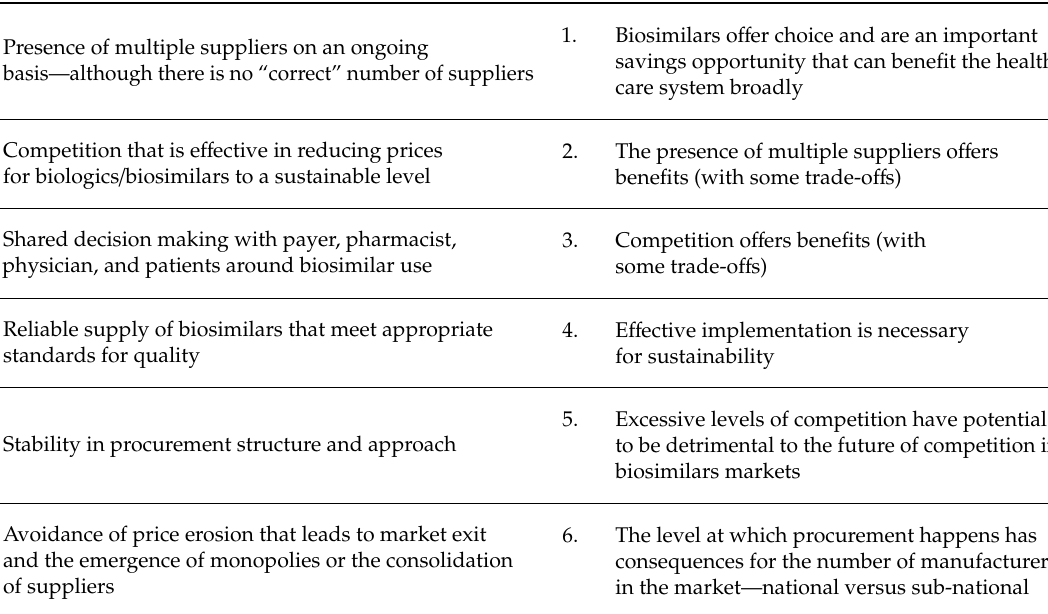
Table A3. Themes and statements (Delphi process stage